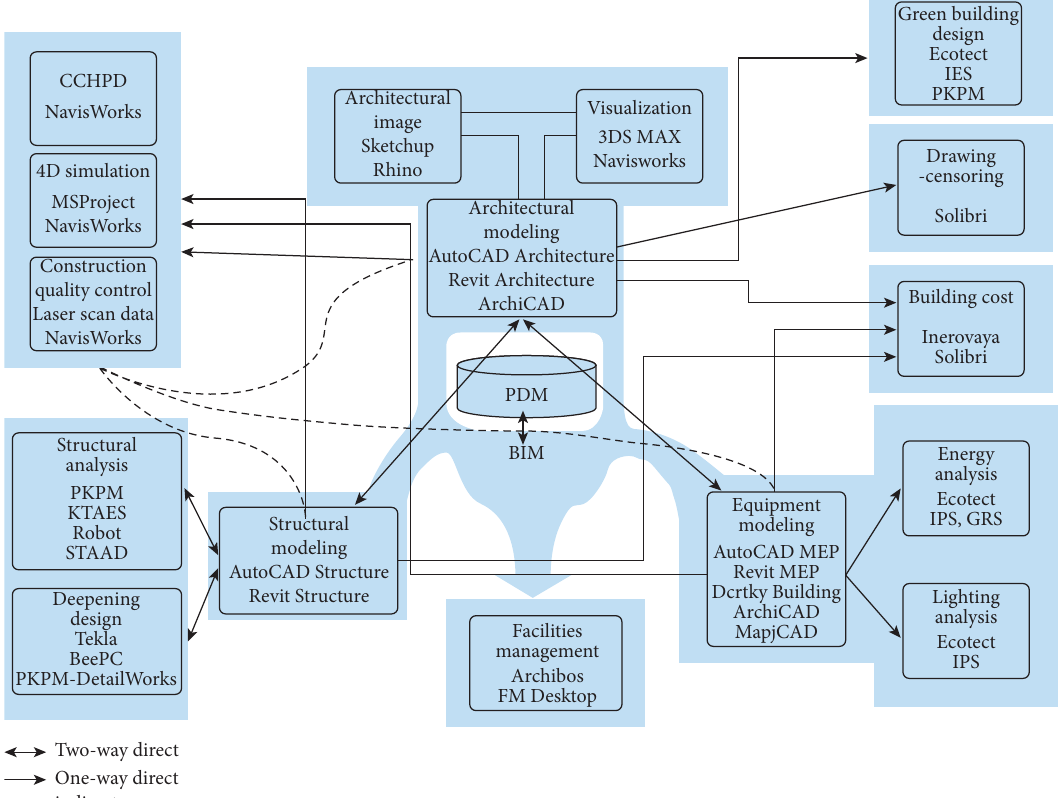
Figure 7: Integrated design information and software relationship based on BIM and PDM.